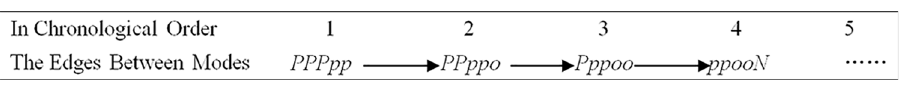
Fig 1. Constructing edges between modes in SMCOP. The arrow represents the edges between